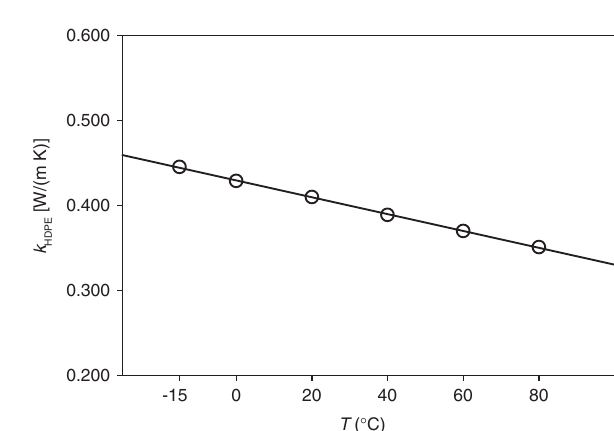
Figure 5 Estimated thermal conductivity of the adopted HDPE [the best-fit line, Eq. (8), is